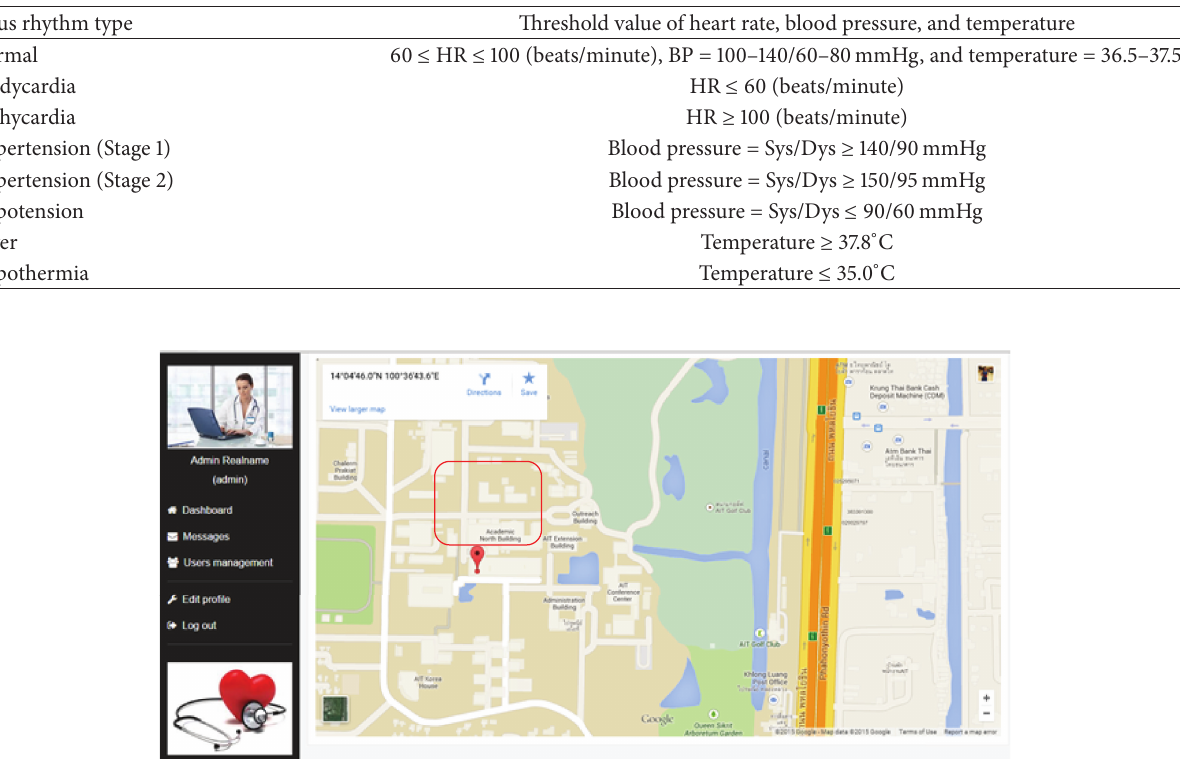
Figure 6: Location record of remote patient monitoring